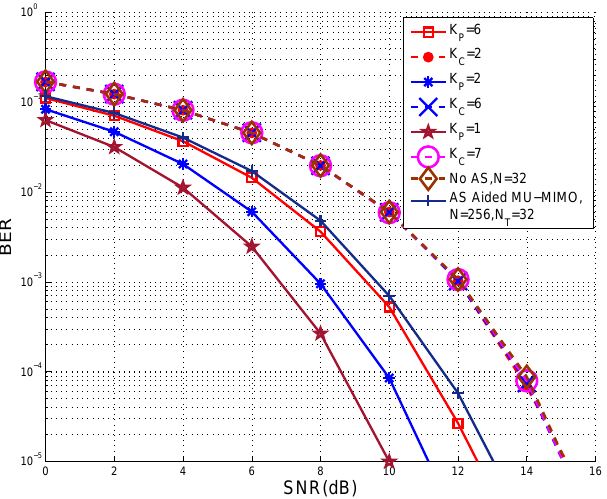
Figure 5. BER performance of proposed UOSTxAS system associated with K = 8 active users, N T = 32 transmit RF chains, and various number of PUs and CUs, in comparison to that of conventional MU-MIMO without AS and AS aided MU-MIMO system.